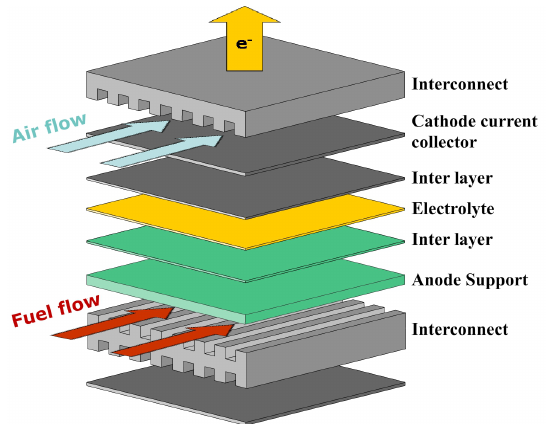
Figure 1. The typical components of a planar solid oxide fuel